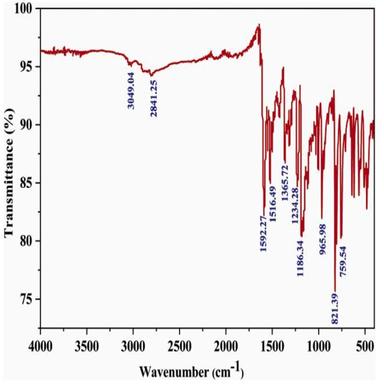
FT-IR spectrum of DADMQ crystal.